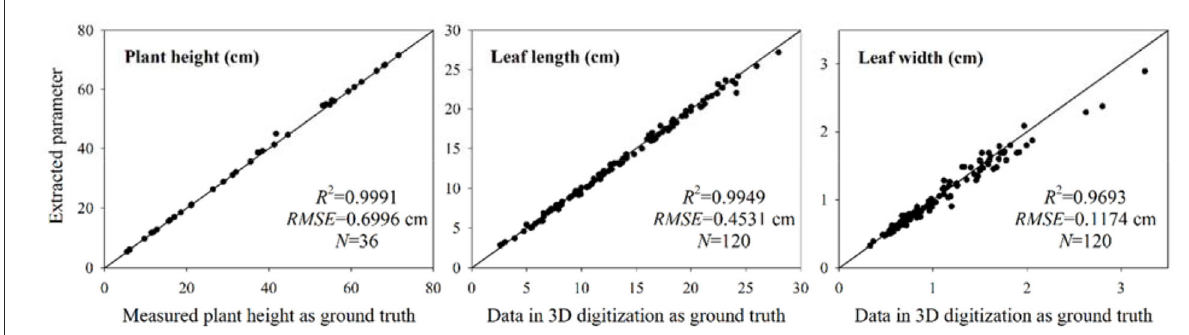
FIGURE12 Accuracy evaluation of the extracted plant height, leaf length, and leaf width. The extracted plant height was compared with the measured values. The measured leaf length and width values from the reconstructed point clouds and the estimated values from the 3D digitization data were compared. The estimated values were regarded as the basis for comparison.